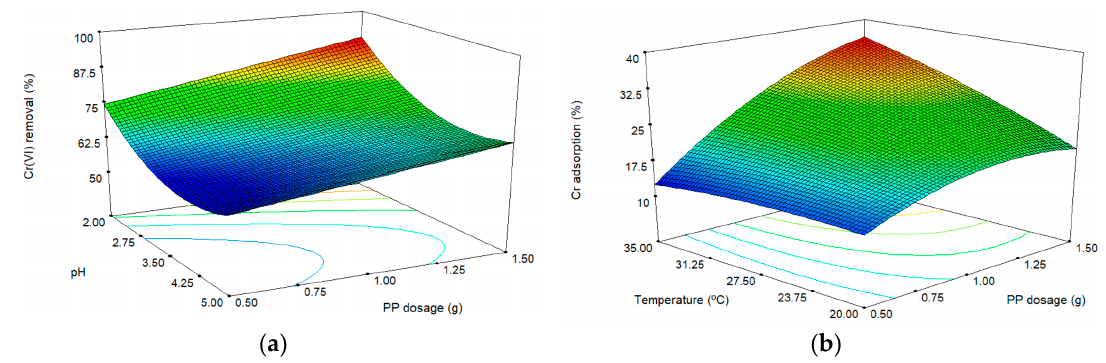
Figure 4. Response surface methodology (RSM) plot: ( a ) Cr(VI) removal to assess the pH and PP dosage with the temperature held constant at central level; ( b ) Cr adsorption to estimate the temperature and PP dosage with the pH held unchanging at the central level.